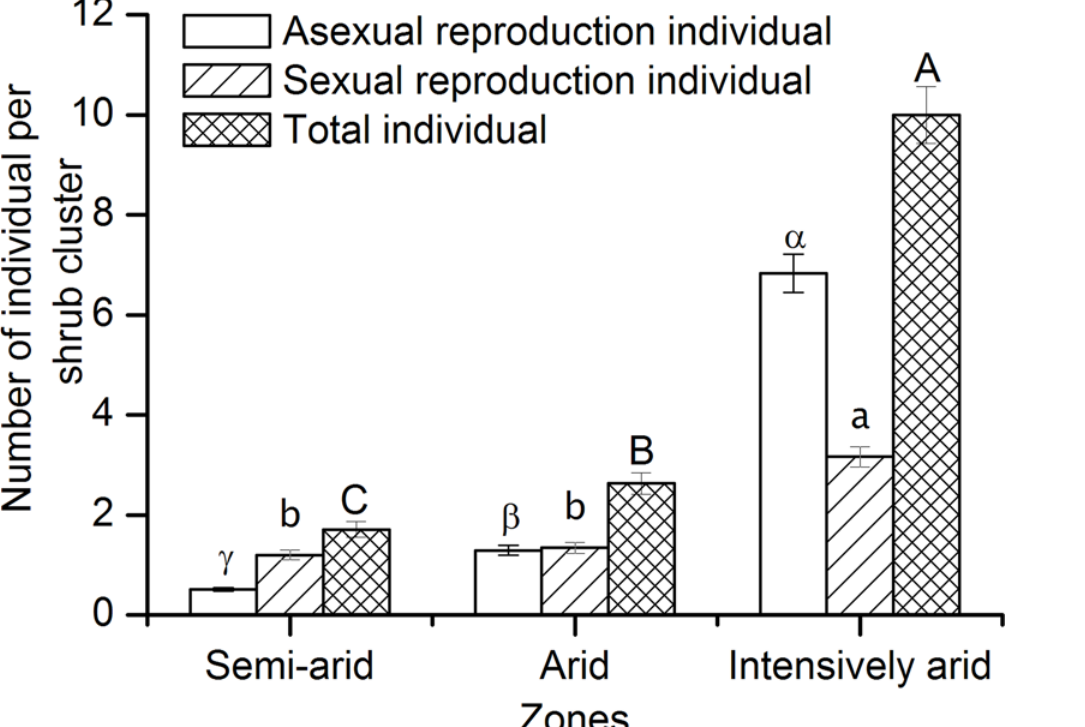
Fig 1. Average abundances of individuals arising from sexual or asexual reproduction and average total numbers of individuals for C . stenophylla shrub clusters in the semi-arid, arid and intensively arid zones (mean ± SE, n = 3). For variables in the same category, different letters (asexual reproduction individual: greek letter; sexual reproduction individual: lowercase; total number of individual: uppercase) indicate significant differences in the means between zones (Tukey HSD tests, P < 0.05).